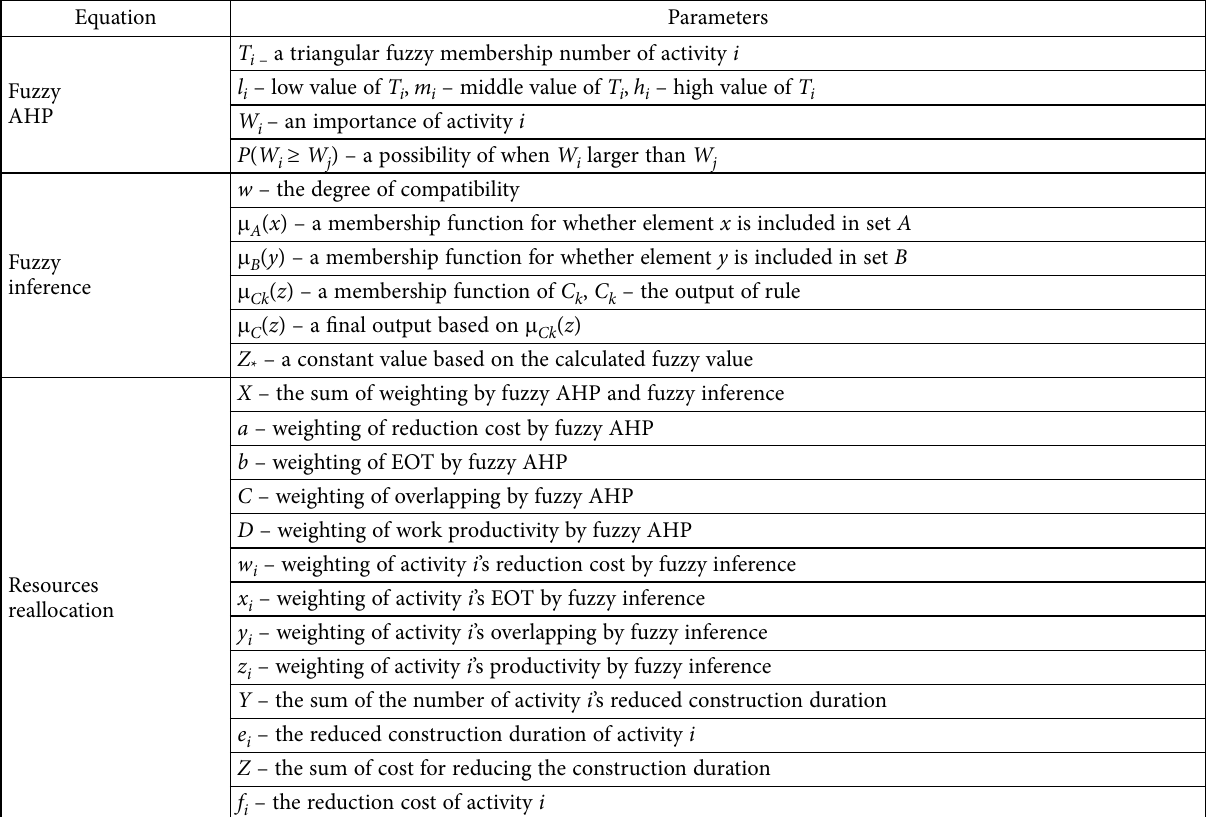
Table A1. The parameters used in this